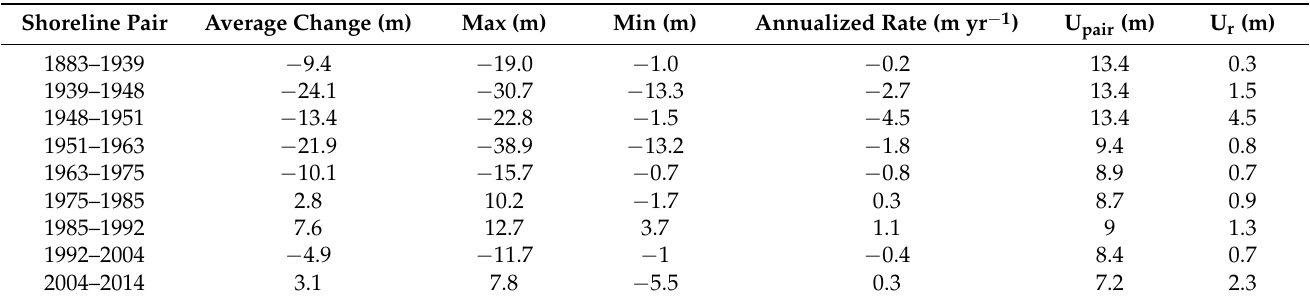
Table 4. Average change in shoreline position, maximum change, minimum change, average annualized rate, positional uncertainty values (U pair ) and rate uncertainty values (U r ) for subsequent shoreline pairs on the Napatree barrier for transects